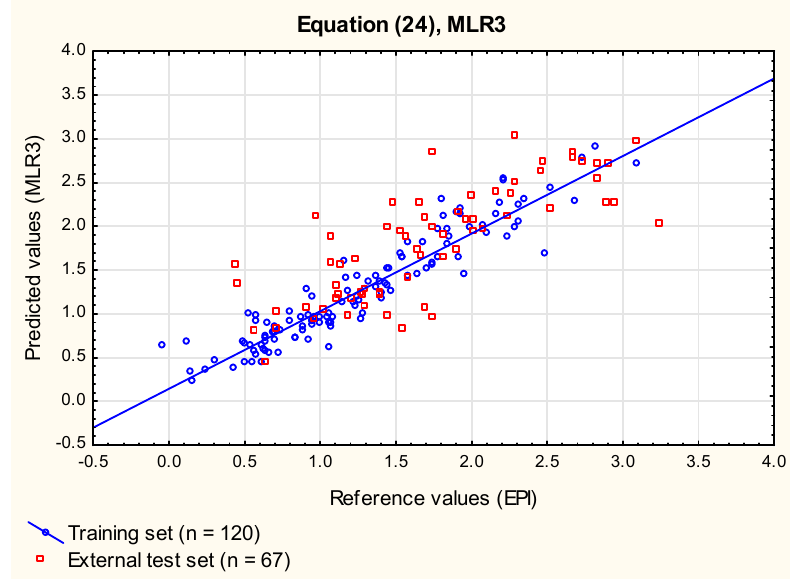
Figure 3. MLR3 model, Equation (24)—predicted vs. reference log BCF values. ( n = 120, R 2 = 0.89, R 2 adj = 0.88, RMSECV = 0.17, RMSEP ext = 0.45, R 2 vivo = 0.83, RMSEP vivo = 0.27, F = 147.3, p <